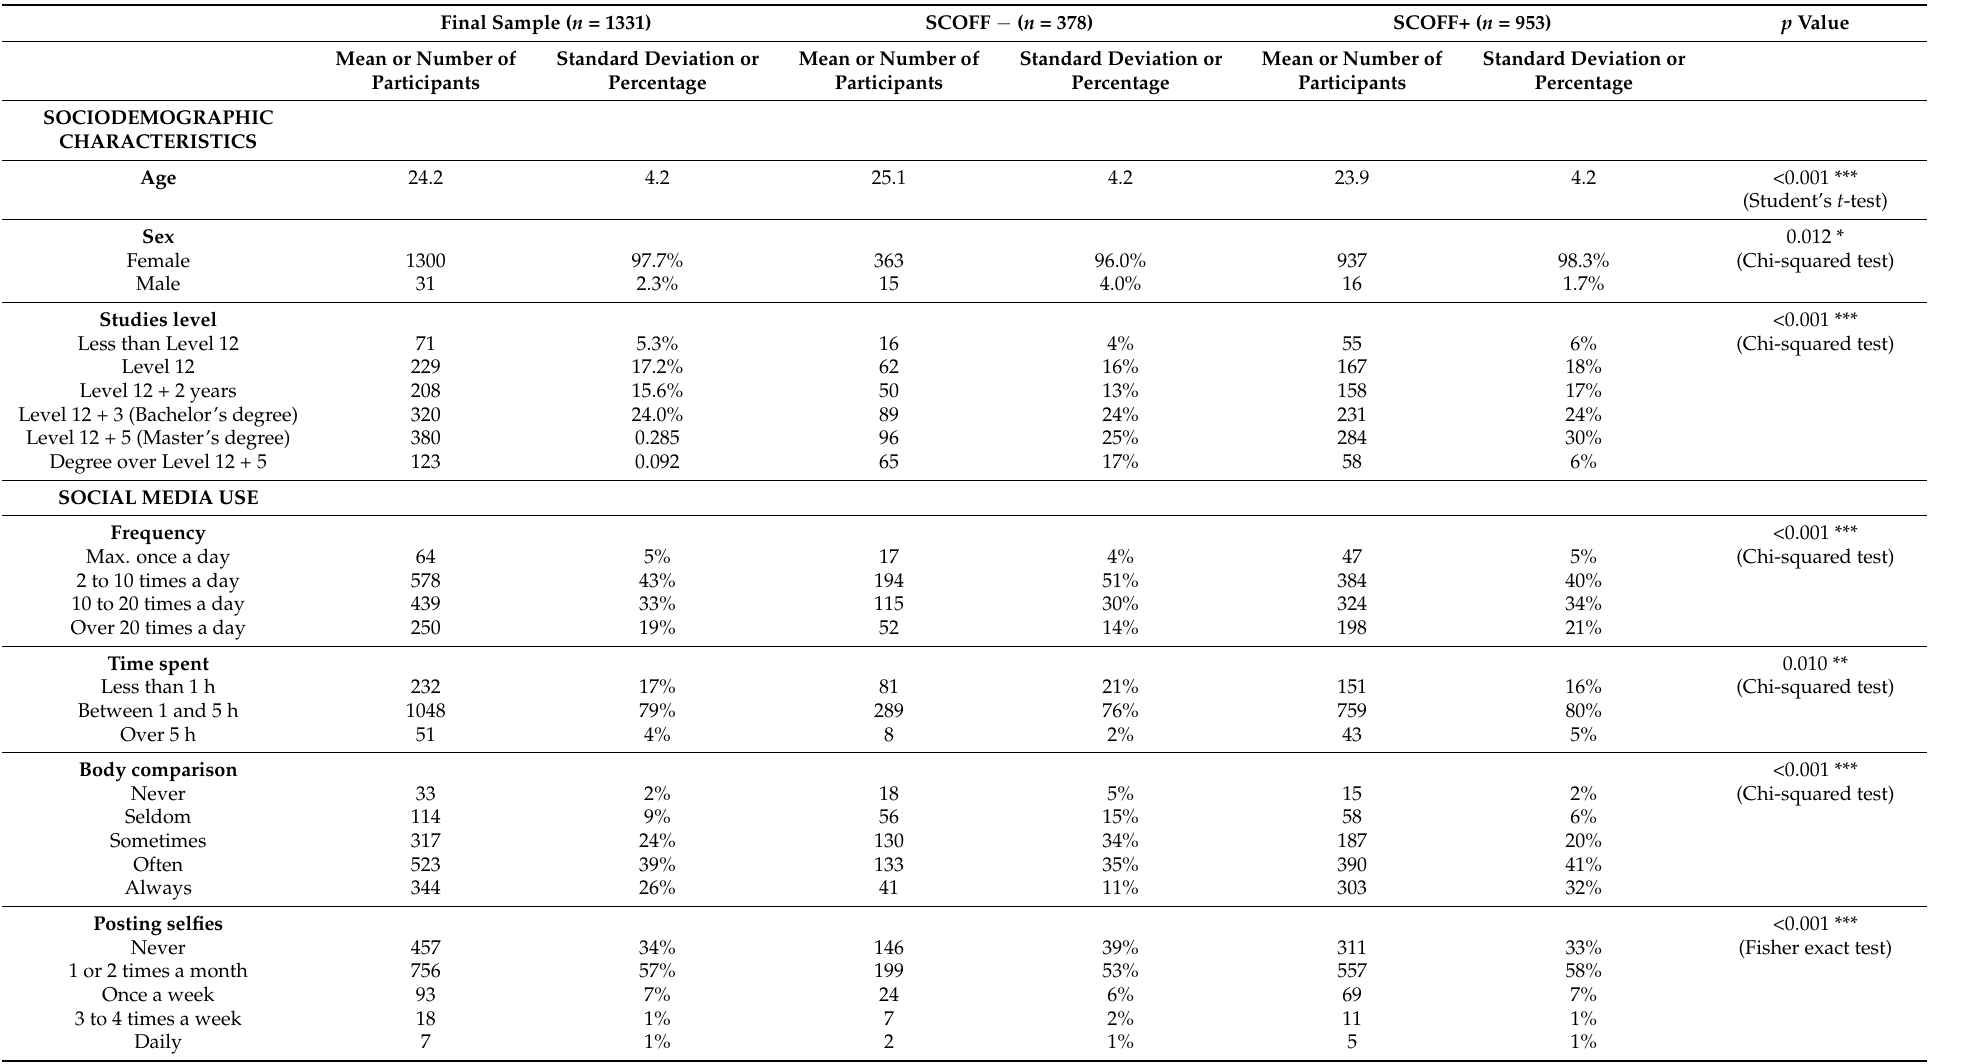
Table 3. Final sample characteristics and comparison between SCOFF+ and SCOFF −